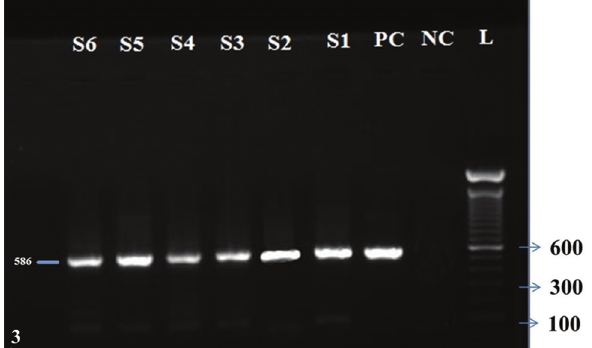
Figure-3: Agarose gel (1%) stained with ethidium bromide. Lane L is the 100 bp ladder, NC is the negative control, PC is a positive control, S1-S6 are the samples that are positive for fluorescent antibody technique.